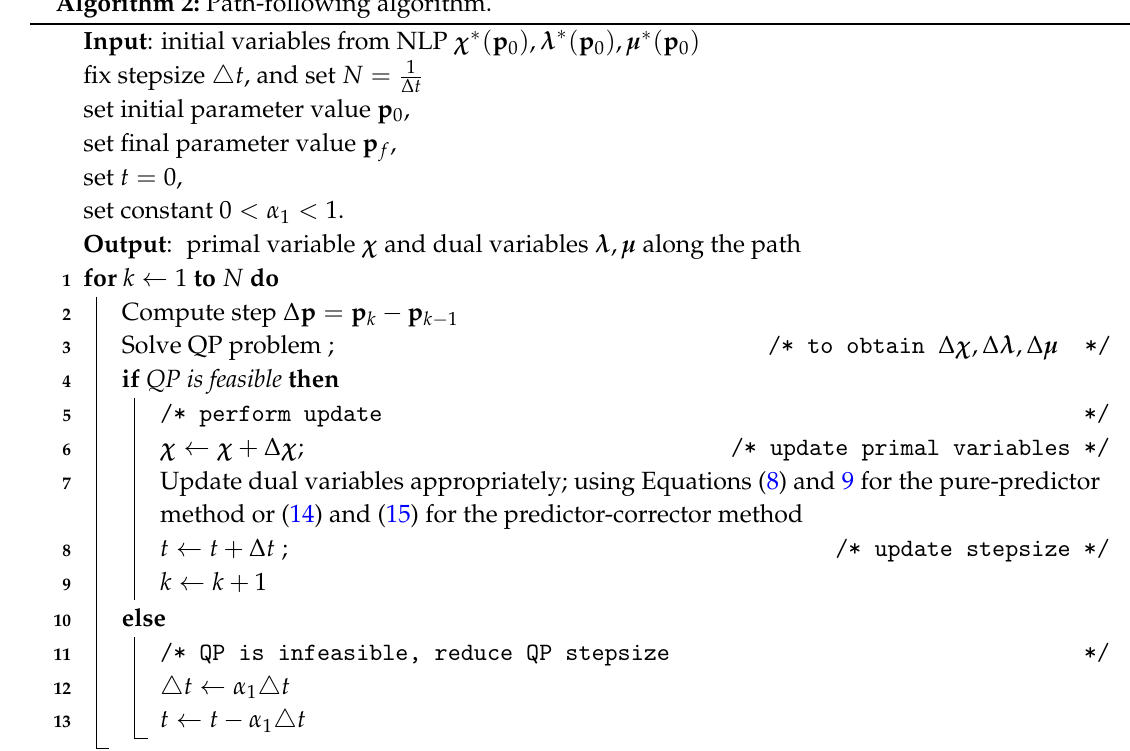
Algorithm 2: Path-following